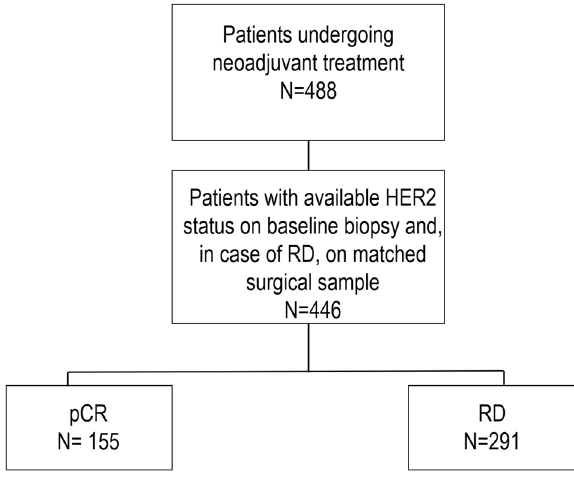
Fig. 1 Flow diagram of the study. This diagram shows the study scheme. N number, pCR pathologic complete response, RD residual disease.